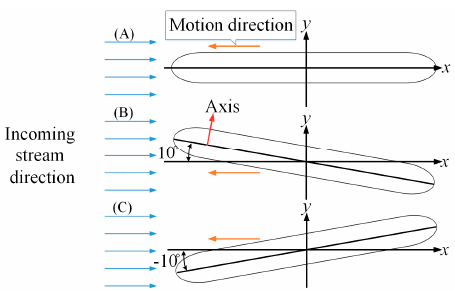
11 of 17 Figure 5. Computing domain. Table 1. Boundary conditions of numerical calculation. Zone